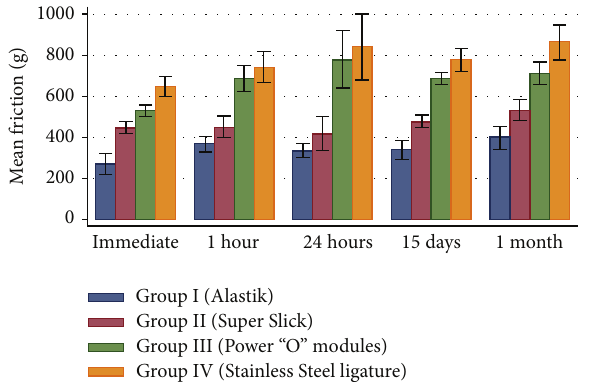
Figure 7: The bar diagram showing the mean static friction with standard deviations within the groups at different time periods (ANOVA